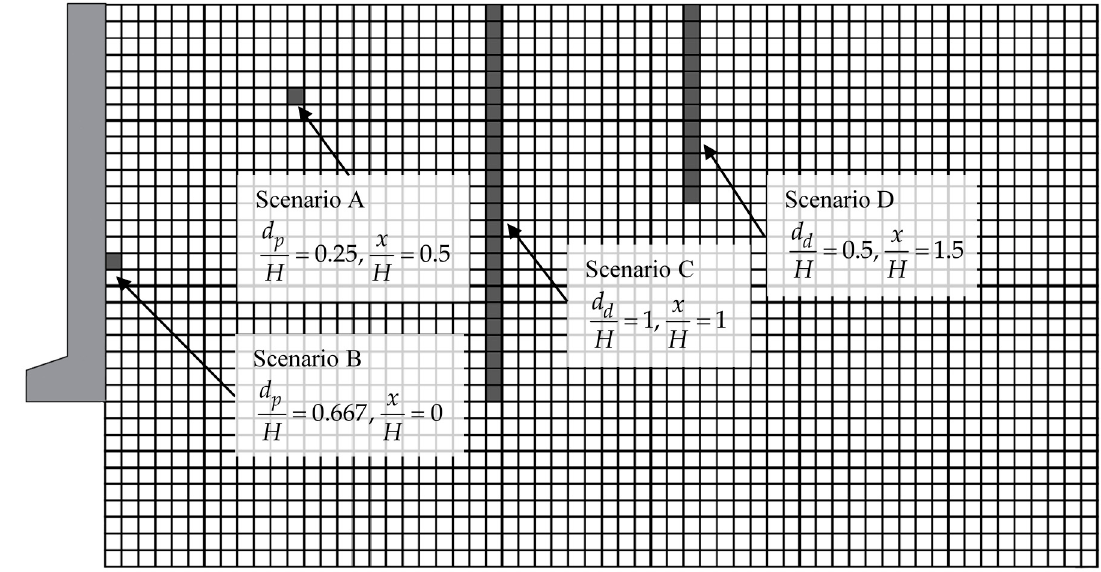
Figure 2. Examples of di ff erent sampling scenarios referring either to a single point (scenarios A and B) or to continuous probing tests (scenarios C and D).